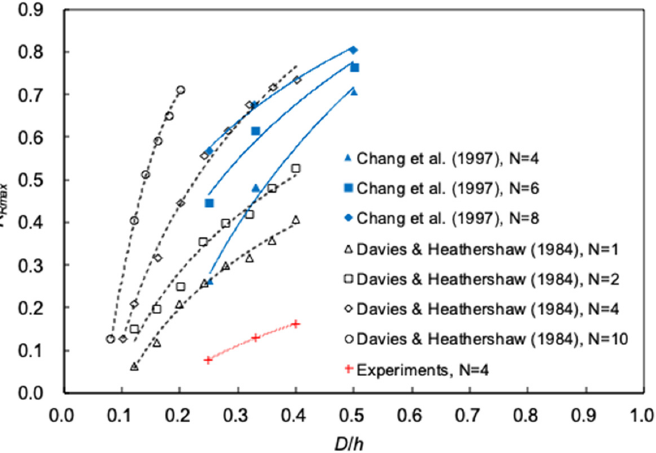
Figure 14. Comparison of the Bragg resonant reflection coefficient peak K Rmax with the relative height D / h (Chang et al. [42], Davies and Heathershaw [14]).